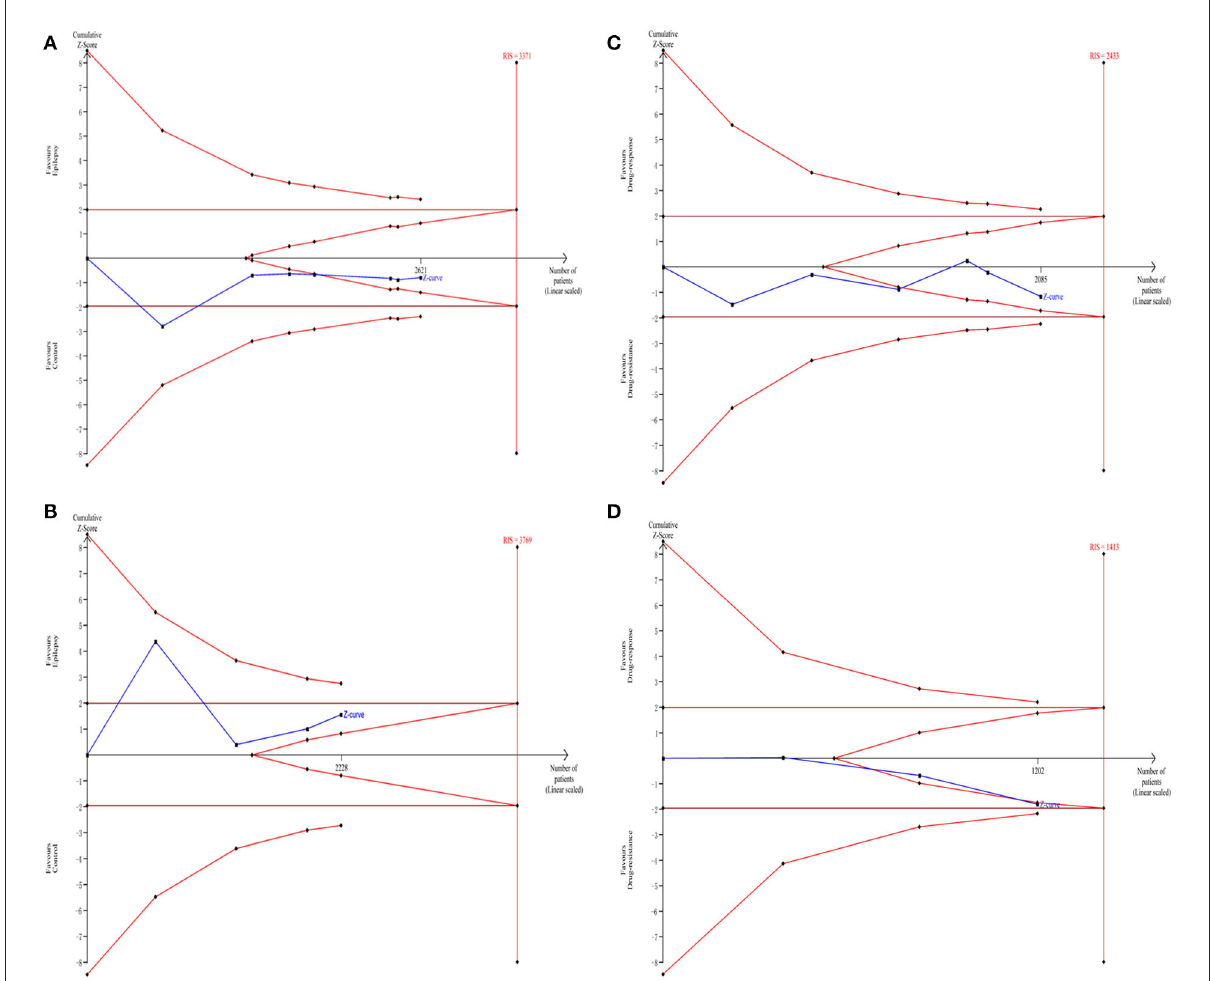
FIGURE3 Trial sequential analysis of the association between rs2279020 and rs3219151 and the risk of epilepsy (A,B) . Trial sequential analysis of the association between rs2279020 and rs3219151 and the risk of drug resistance (C,D) . RIS, required information